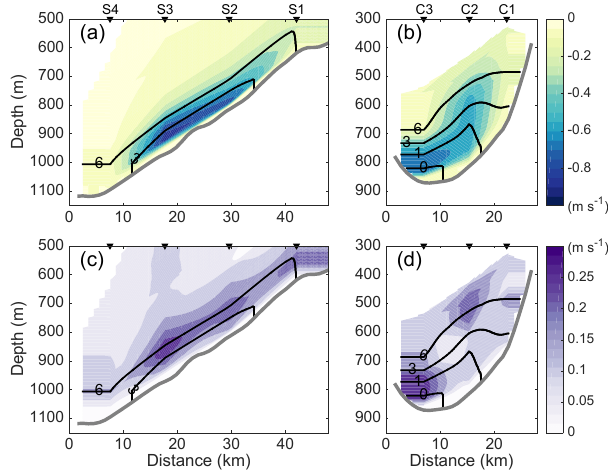
Figure 4. Cross-sectional distribution of along-stream velocity u (ms − 1 ), in colour, with average isotherms ( ◦ C) overlaid as black contours. Time-average (a, b) and standard deviation (c, d) of daily data over the common period 30 May 2012–17 January 2013 when complete records exist at both sections: (a, c) section S and (b, d) section